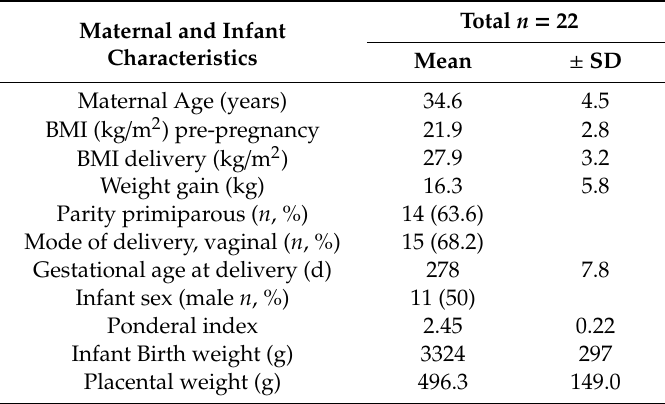
Table 1. Maternal and fetal characteristics of study